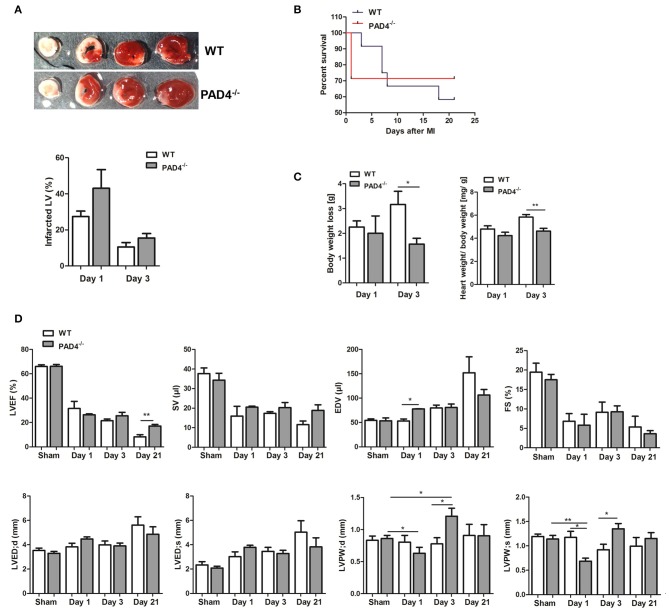
PAD4−/− mice show better recovery at post-acute stages. (A) Quantification of infarct sizes at day 1 (n = 3) and day 3 (n = 5) post-MI. (B) Survival curves of WT and PAD4−/− mice subjected to permanent LAD ligation for 21 days (n = 7–12). (C) Weight loss and heart to body weight ratio in WT and PAD4−/− mice at day 1 and day 3 post-MI. n = 3–5. (D) LVEF, SV, EDV, and FS were determined at days 1 (n = 3), 3 (n = 8), and 21 (n = 4–5) post-MI by transthoracic echocardiography. Additionally, differences in cardiac dimensions (LVED;d, LVED;s, LVPW;d, LVPW;s) between mice were quantified. *p < 0.05; **p < 0.01 determined by Student t-test.